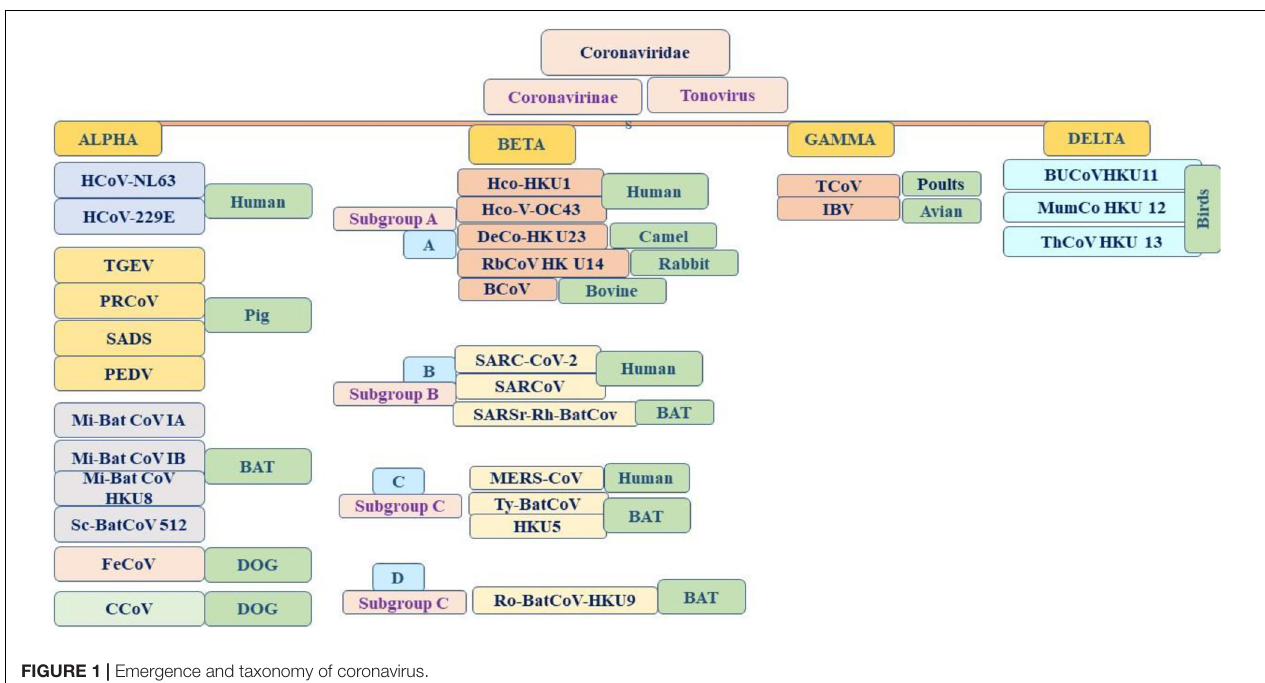
FIGURE 1 | Emergence and taxonomy of coronavirus.